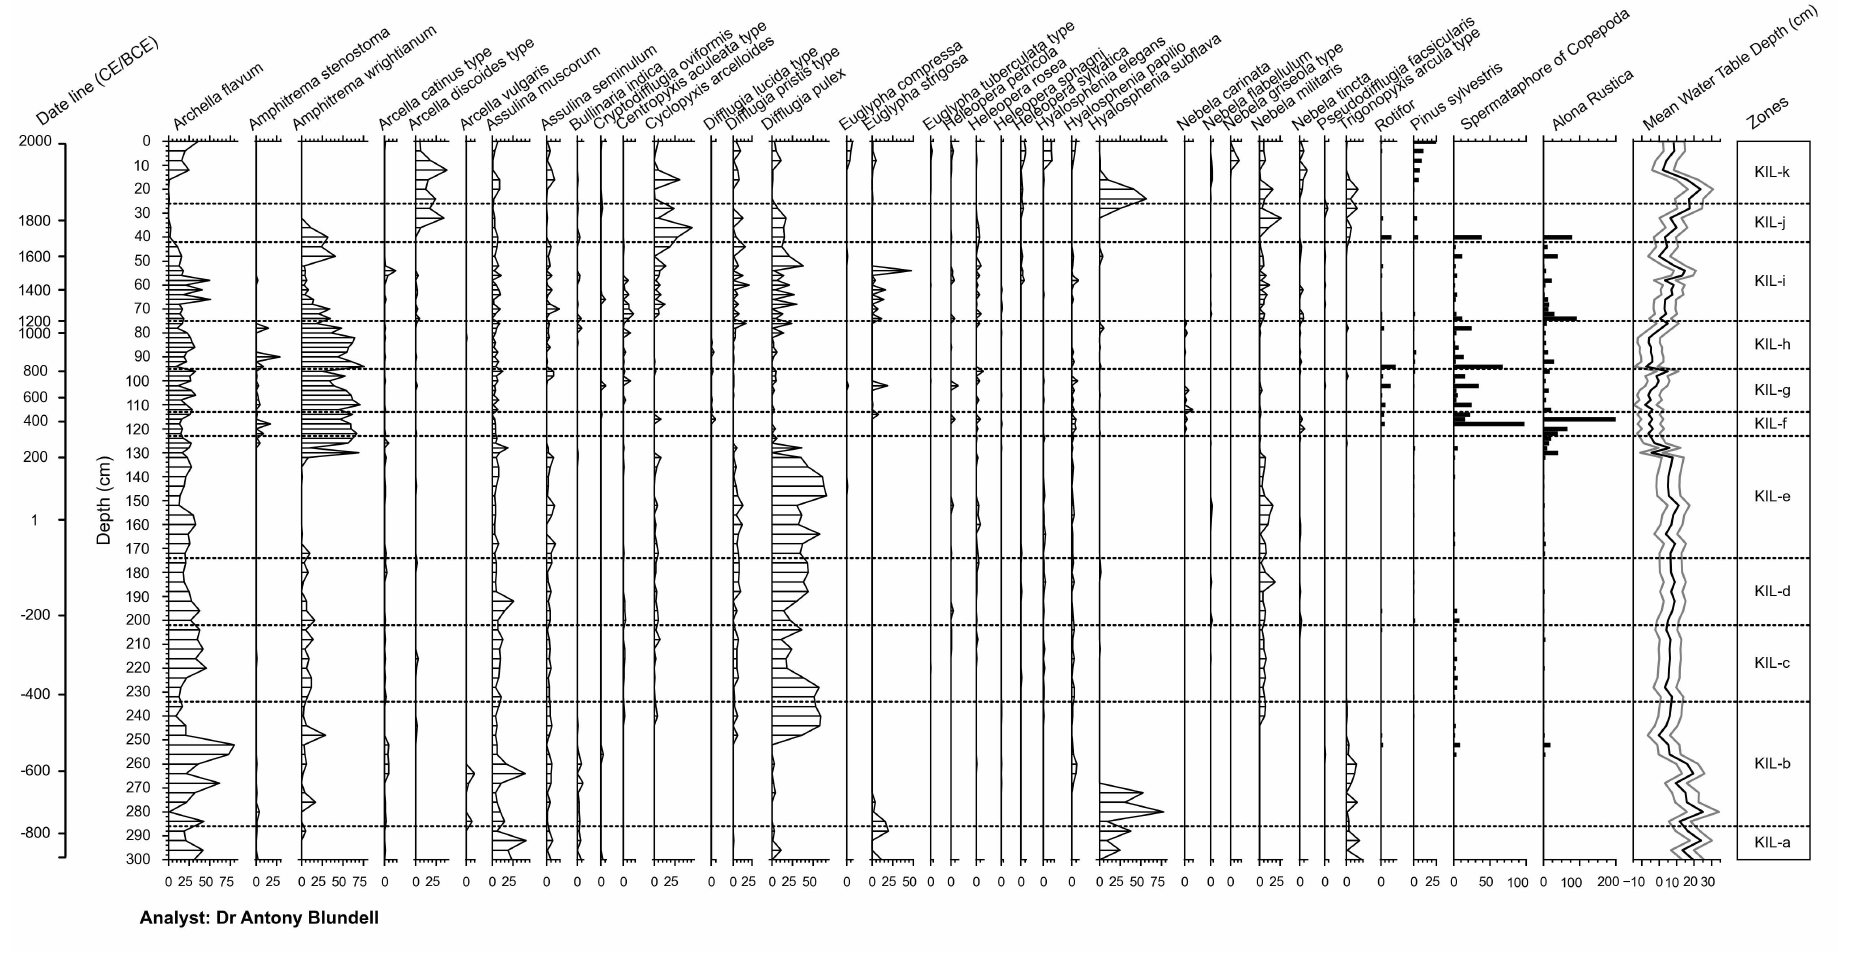
Figure 4. Testate amoebae diagram for Killorn Moss. All testate data are percentages of the total number counted per depth level. Bar graphs are absolute counts. Depth to water table reconstruction in centimetres from transfer function (Charman et al . 2007) together with associated errors derived from bootstrapping are